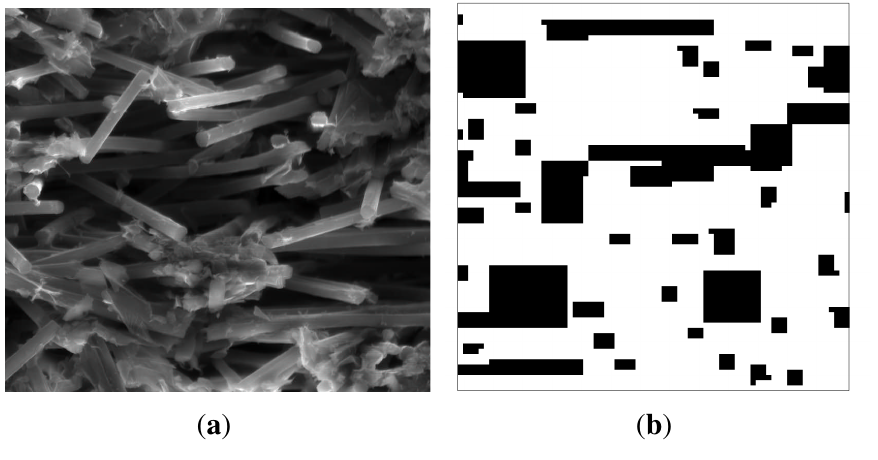
Figure 3. ( a ) Cross-section of a Toray TGP-H-060 with 20 wt% PTFE (edge length is 200 µ m) and ( b ) the 2D representation for the same type of